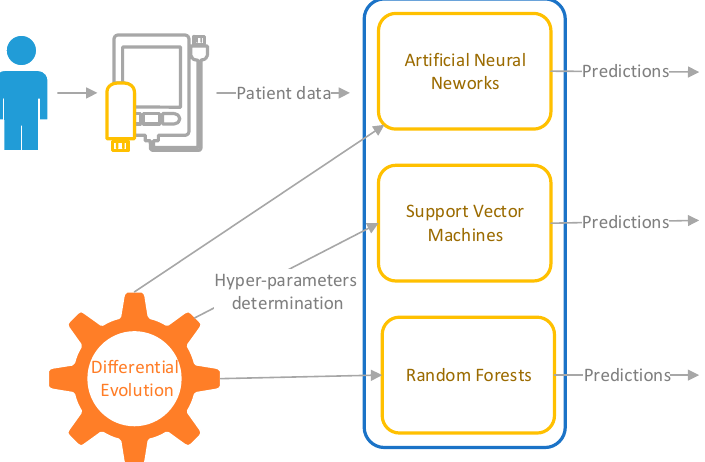
Figure 2. Workflow for data classification.